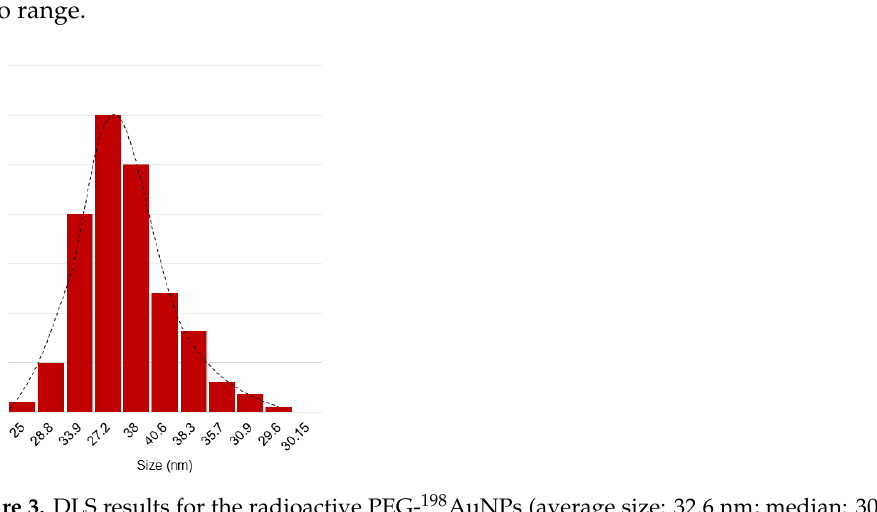
Figure 3. DLS results for the radioactive PEG- 198 AuNPs (average size: 32.6 nm; median: 30.9 nm; standard deviation: 5.1 nm).